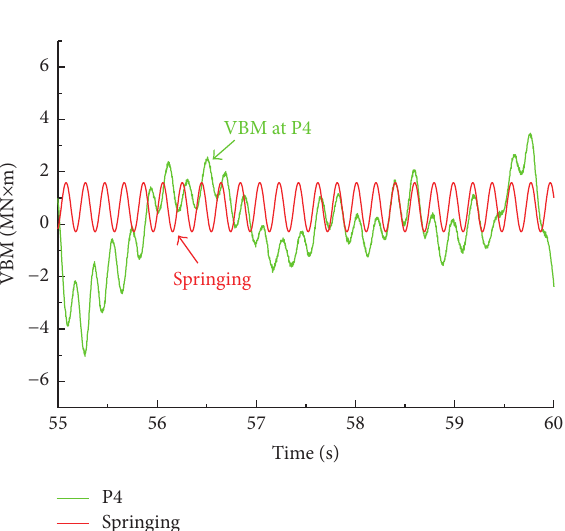
Figure 21: VBM time histories of springing.